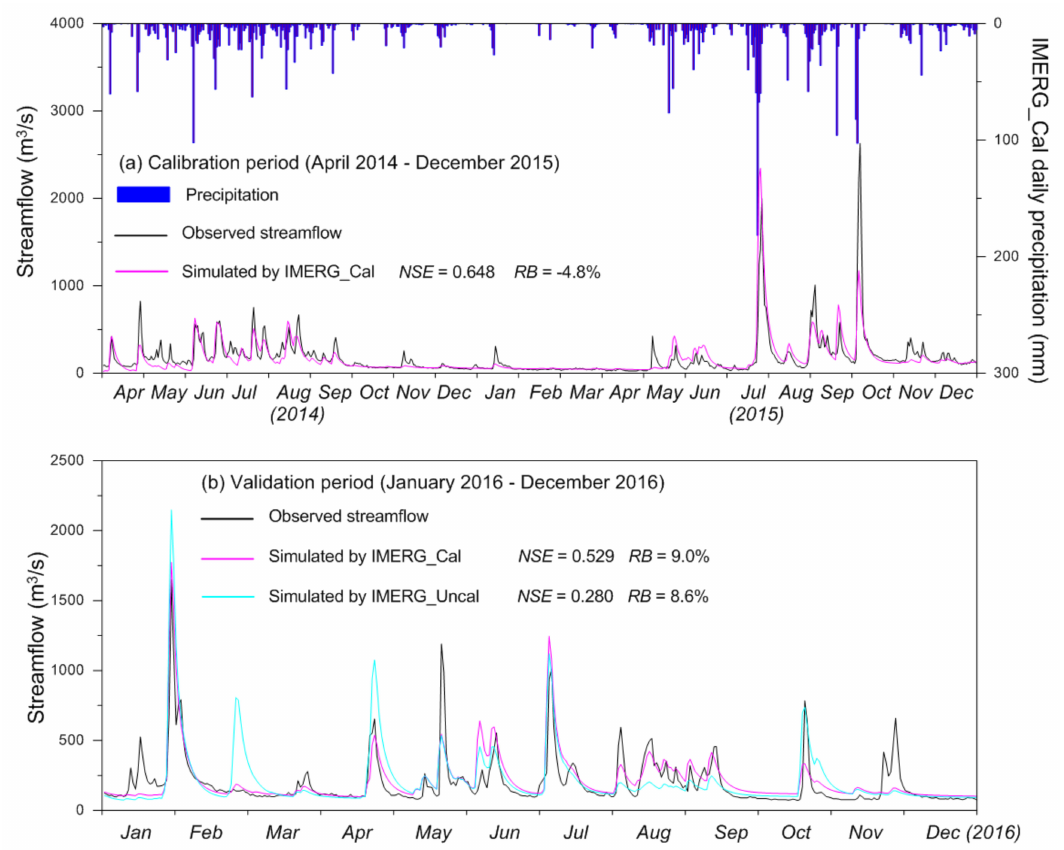
Figure 8. Same as Figure 7 but the model was calibrated by the IMERG